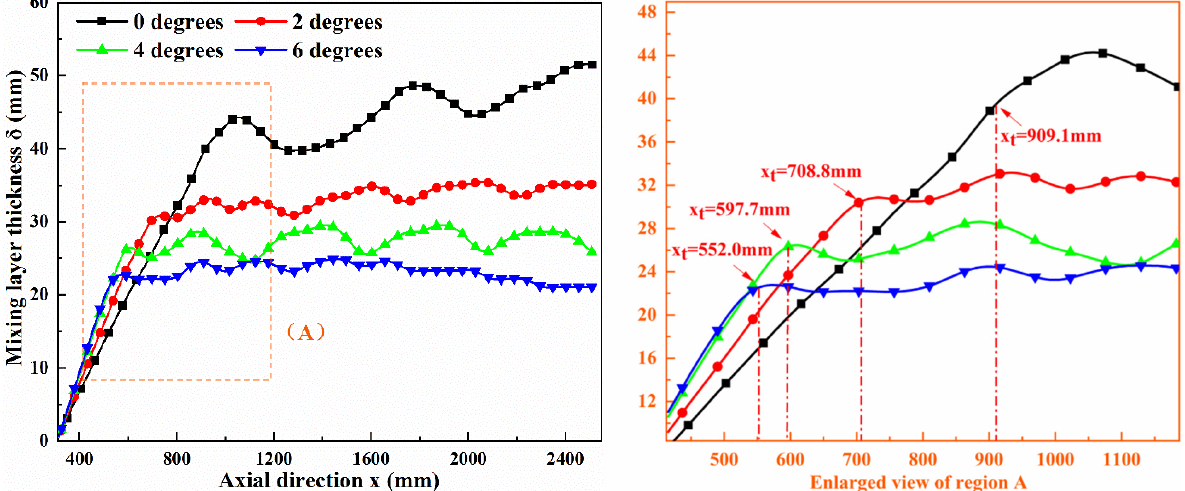
Figure 12. Thickness development of mixing layer during different φ (region A is enlarged to show the linear growth interval of the mixing layer clearly).